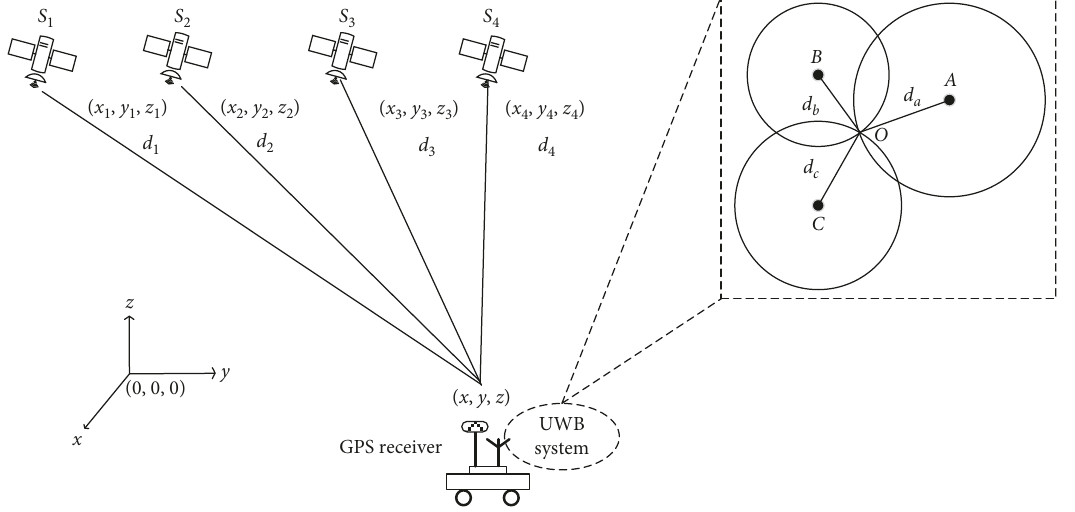
Figure 1: GPS/UWB collaborative positioning